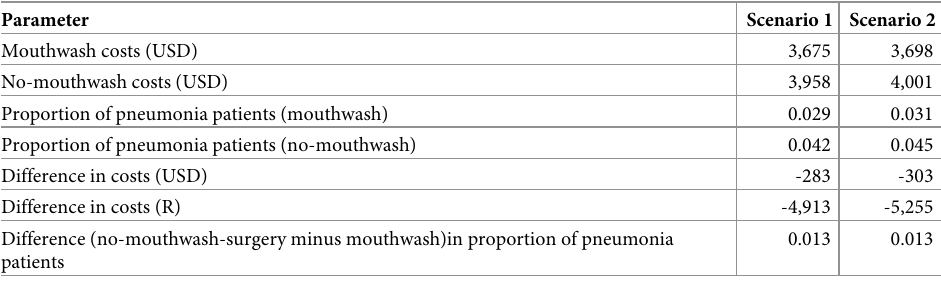
Table 5. Base case cost-effectiveness